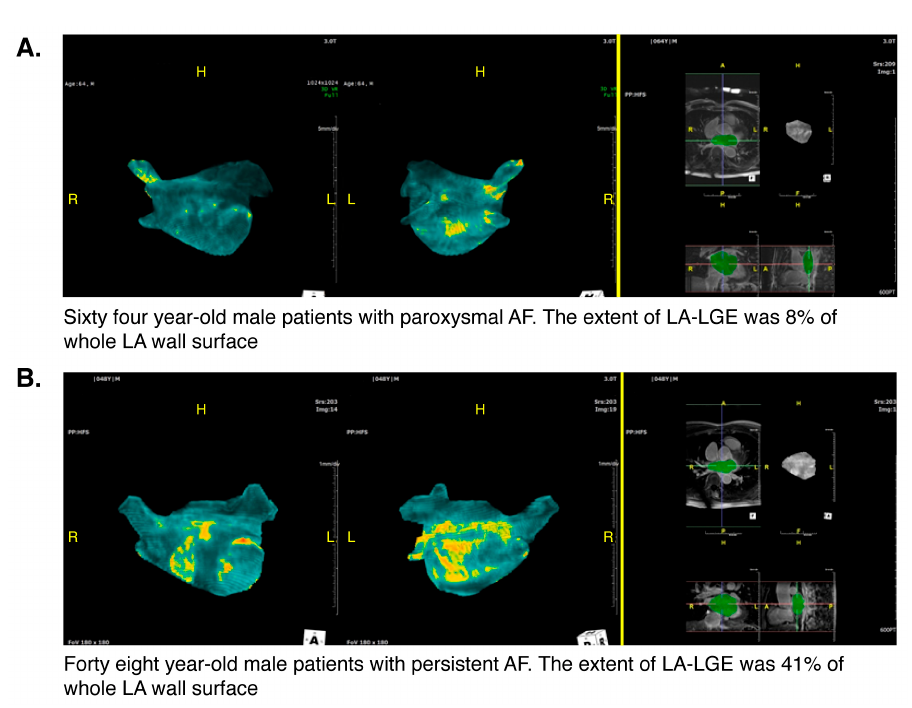
Figure 2. Processed 3D reconstructions showing low and high late gadolinium enhancement in cardiac magnetic resonance images (MR LGE) within left atrium (LA) walls. ( A ) A 64-year-old man with paroxysmal AF. ( B ) A 48-year-old man with persistent AF. paroxysmal AF. ( B ) A 48-year-old man with persistent